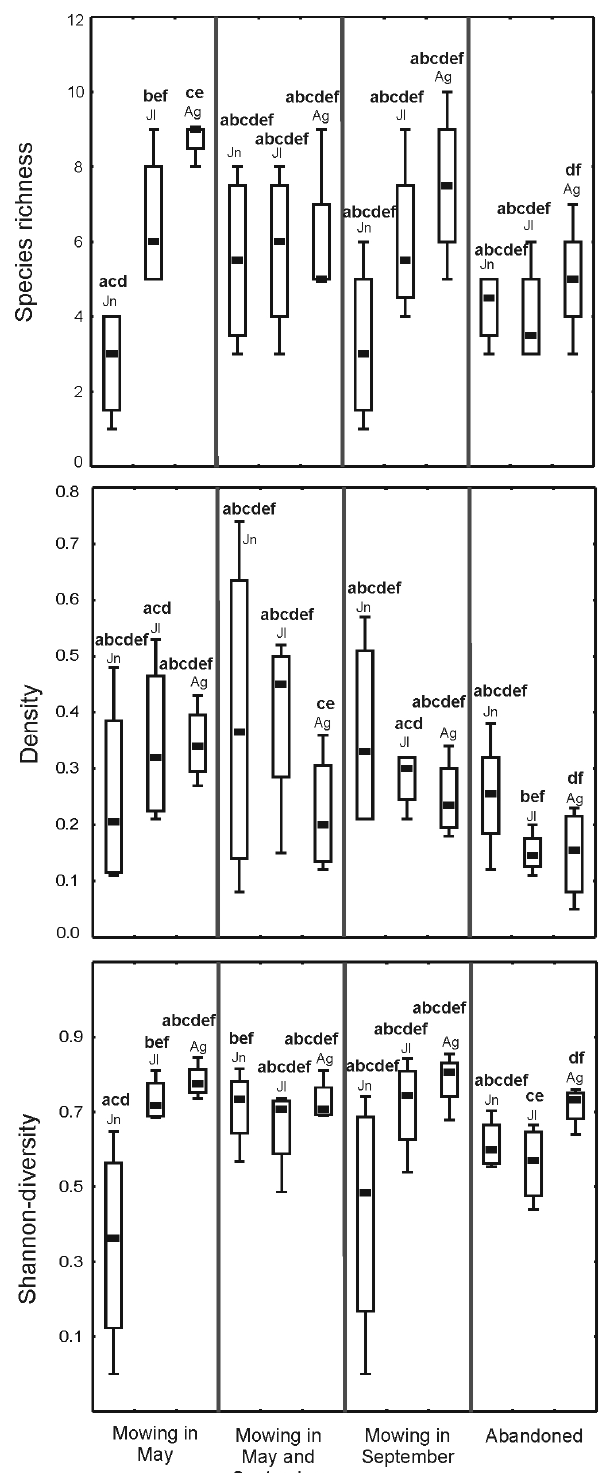
Figure 5. Box-plots (median values with minimum, maximum and ±SE) of nymphal density (specimen/m 2 ) of orthopterans in four treatment types (mowing once a year in May; mowing twice a year in May and September; mowing once a year in September; abandoned) in June (Jn), July (Jl) and August (Ag). Significant (p<0.05) differences detected by Mann-Whitney U test are indi- cated by different